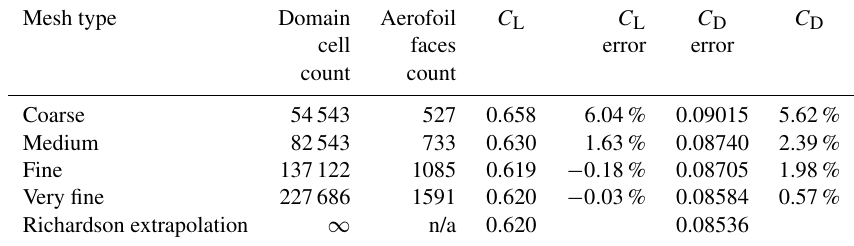
Table 2. Grid independence study for the scanned blade with spoiler at α = 0 ◦ and Re c = 3 × 10 6 . Mesh type